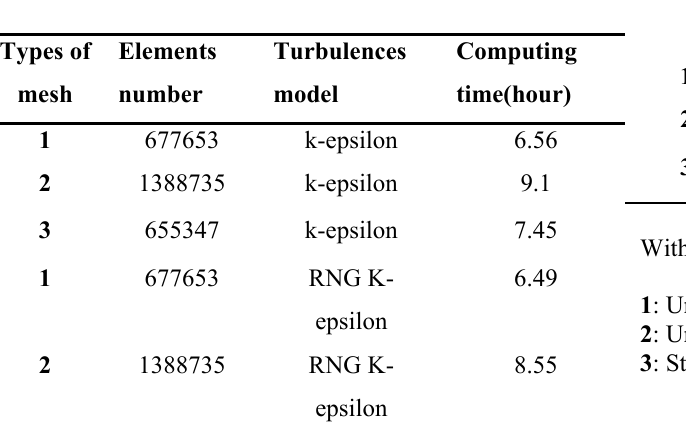
Table 4. Plan of simulation